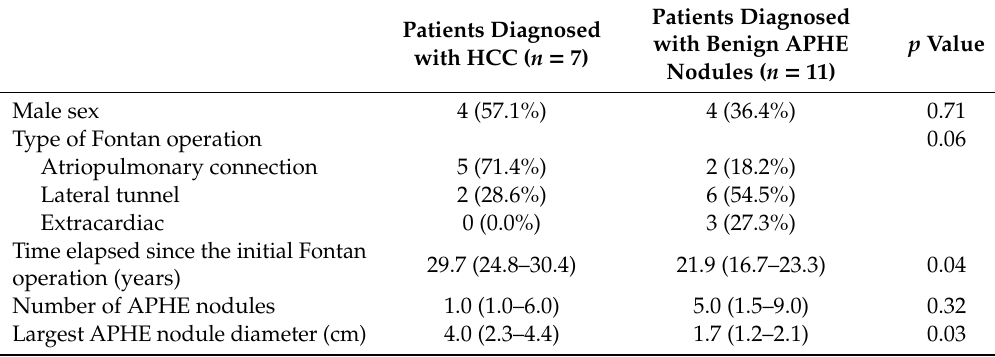
Table 3. Comparison of clinical characteristics between patients diagnosed with HCC and benign APHE nodules after the Fontan